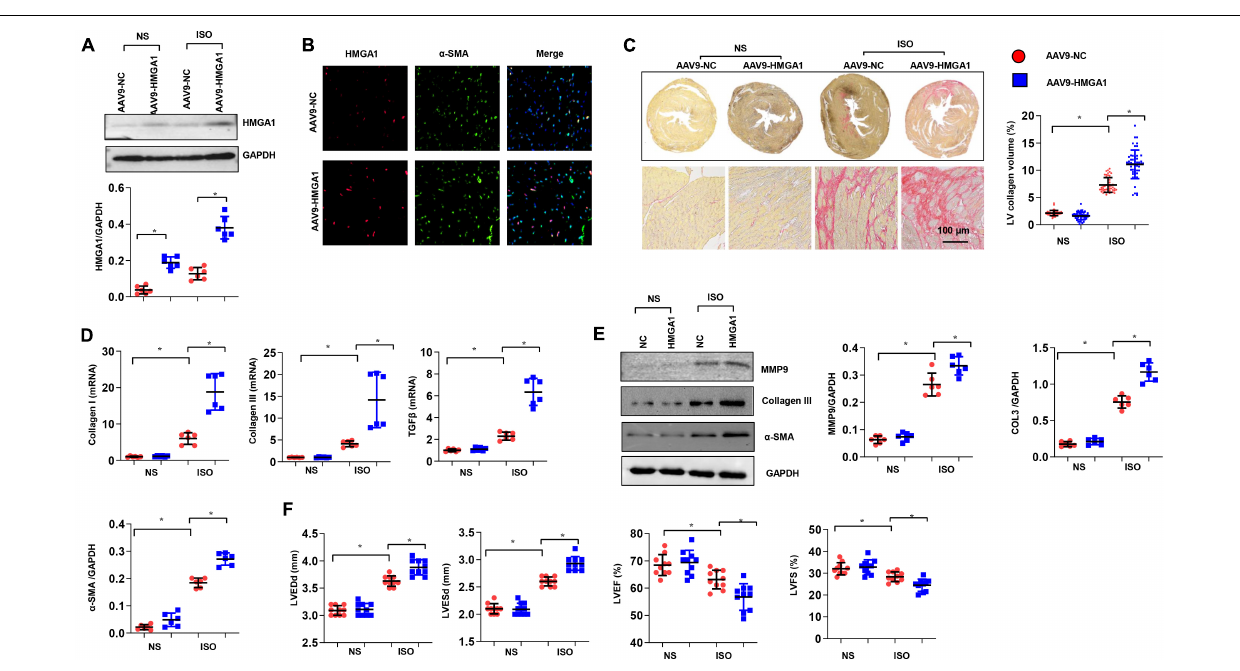
FIGURE 3 | High-mobility group A1 (HMGA1) overexpression contributed to ISO-induced cardiac fibrosis in vivo . (A) The protein level of HMGA1 in mouse hearts 3 weeks after AAV9-HMGA1 injection ( n = 6). (B) Immunofluorescence staining of HMGA1 and α -SMA in heart tissue post-AAV9-HMGA1 injection and ISO injection ( n = 5). (C) Picrosirius red (PSR) staining image and quantitative result of left ventricular collagen volume in mouse hearts after ISO treatment ( n = 5). (D) Transcription levels of collagen I, collagen III, and TGF β 1 ( n = 6). (E) Protein levels of MMP9, collagen III, and α -SMA in heart tissue ( n = 6). (F) Echocardiographic results in each group ( n = 10). * p <